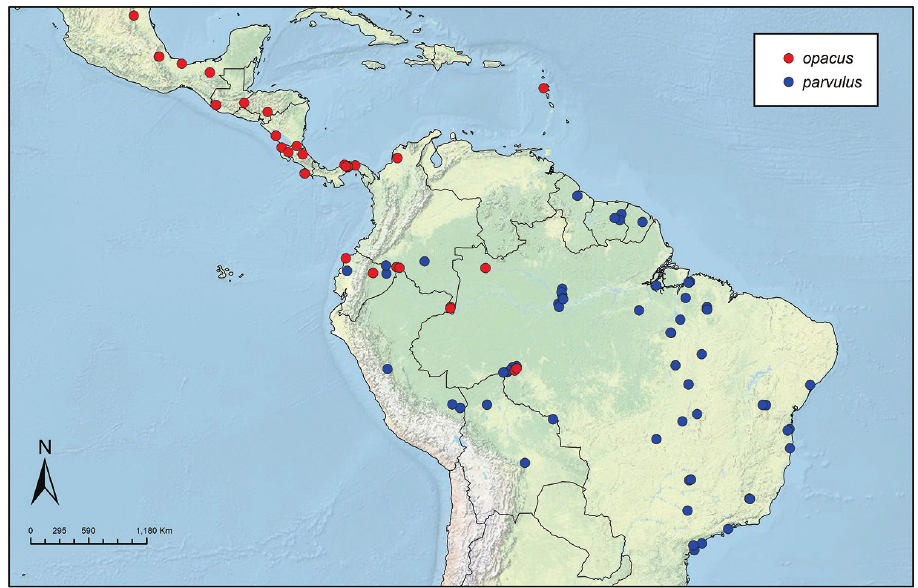
Figure 47. Distribution map of S. opacus and S.